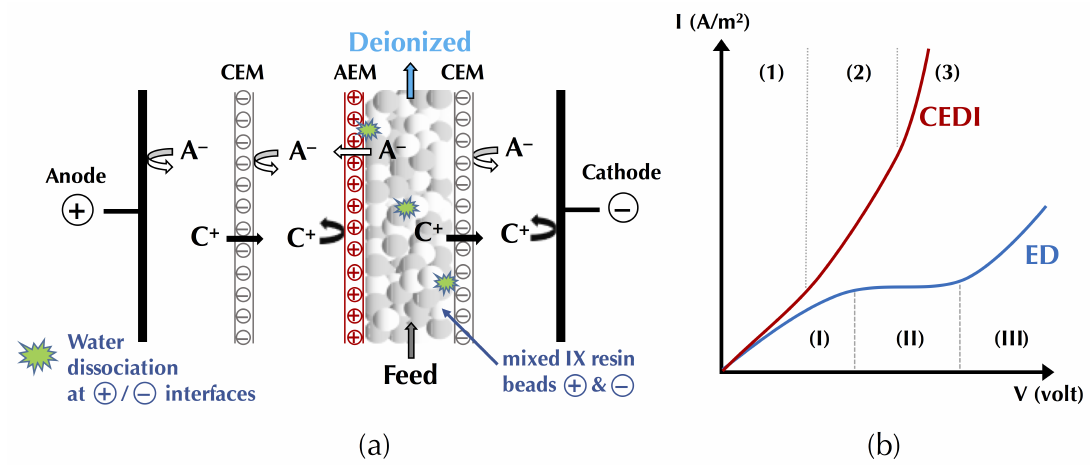
Figure 20. ( a ) Principle of continuous EDI (CEDI) and ( b ) current regimes in CEDI and ED (adapted from Hakim et al. [205]). CEM: cation-exchange membrane; AEM: anion-exchange membrane; IX: ion-exchange; A − : anions; C + :